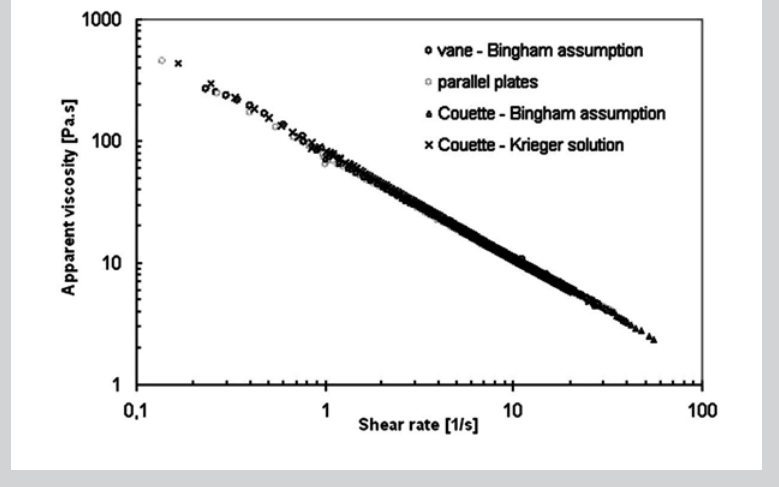
Figure 3: Flow curves for 0.15 wt% of carbopol